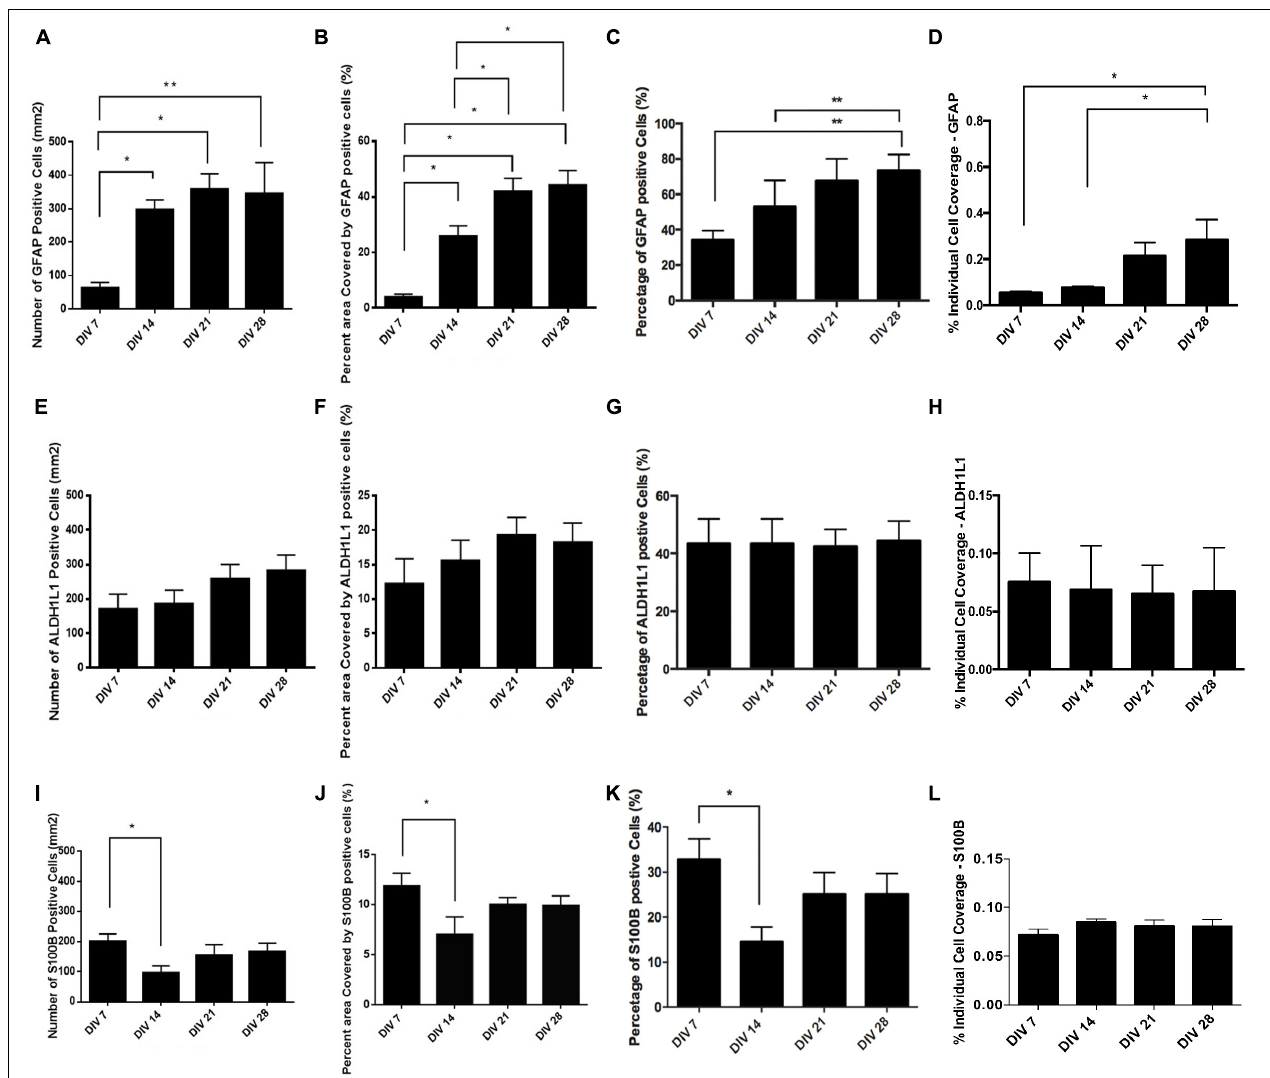
FIGURE 3 | Quantification of astrocyte marker expression: (A–D) – GFAP, (E–H) – ALDH1L1, (I–L) – S100B. (A,E,I) absolute number of marker positive cells per mm 2 . (B,F,J) Percent (%) area covered by marker positive cells. (C,G,K) Percent (%) of marker positive cells. (D,H,L) Percent of area covered by an average marker positive cell. Data expressed as mean ± SEM from three separate experiments, ∗ P < 0.05 and ∗∗ P <